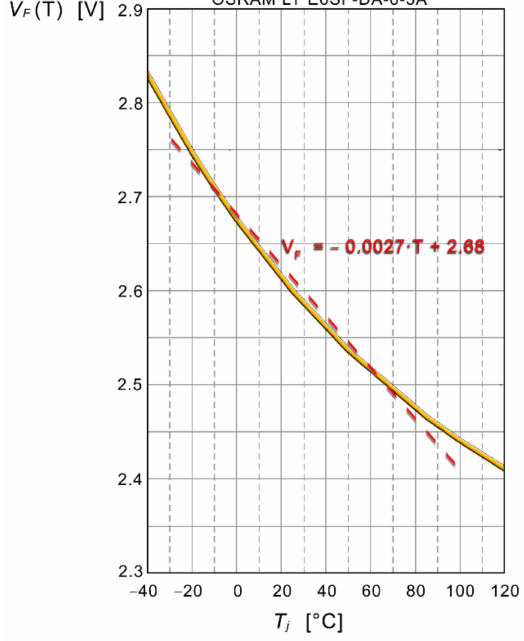
Figure 10. LY E6SF LEDs: forward voltage vs. temperature (current 50 mA).